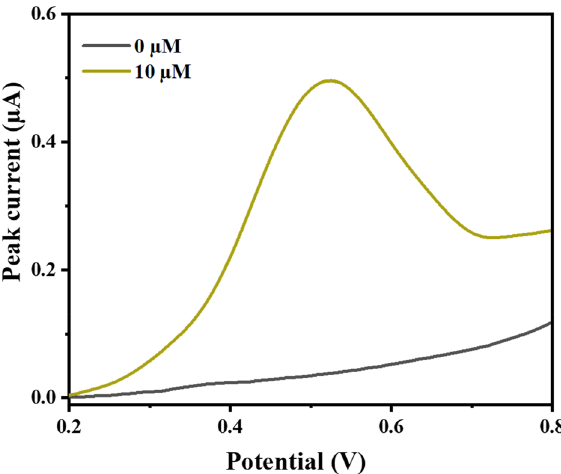
Figure 6. DPV voltammogram recorded at AgNPs-M/GCE for 0 µM and 10 µM of phenol concentrations.